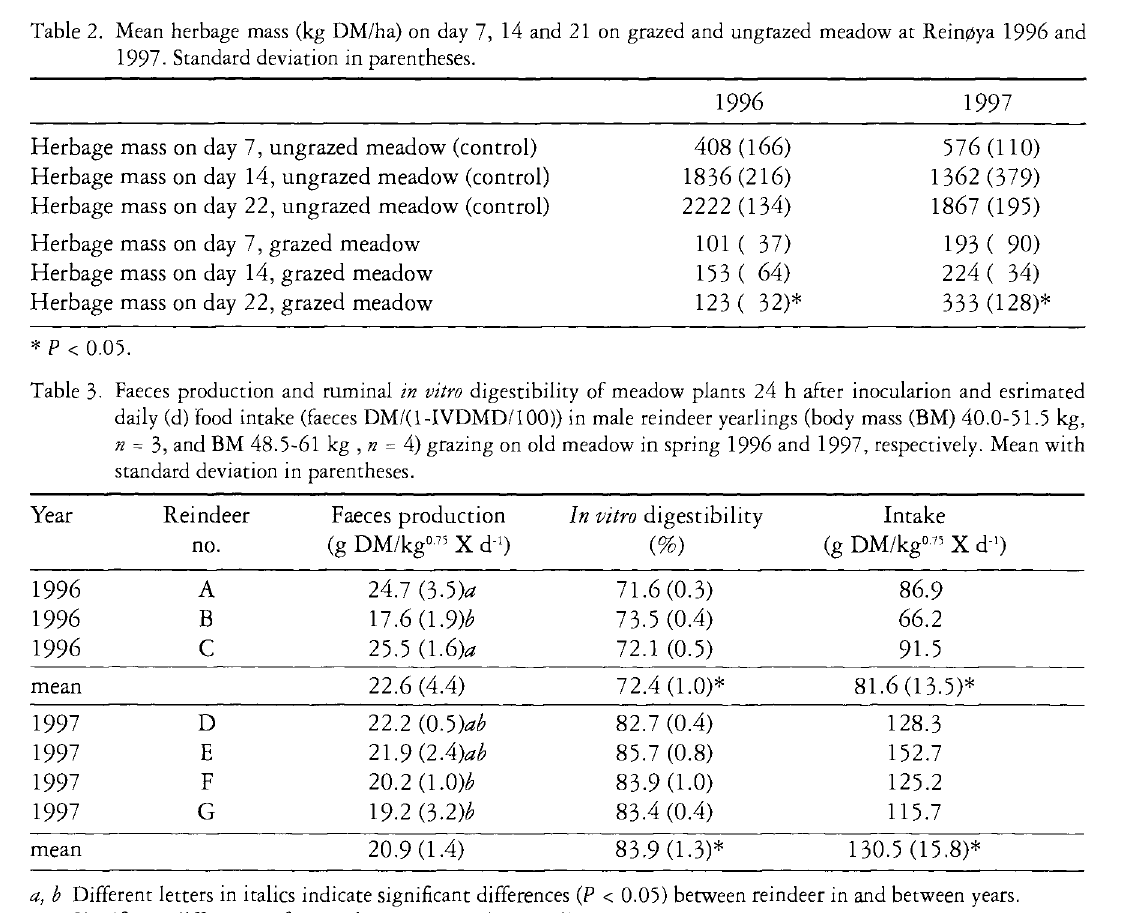
Table 2. Mean herbage mass (kg DM/ha) on day 7, 14 and 21 on grazed and ungrazed meadow at Reinøya 1996 and 1997. Standard deviation in parentheses.